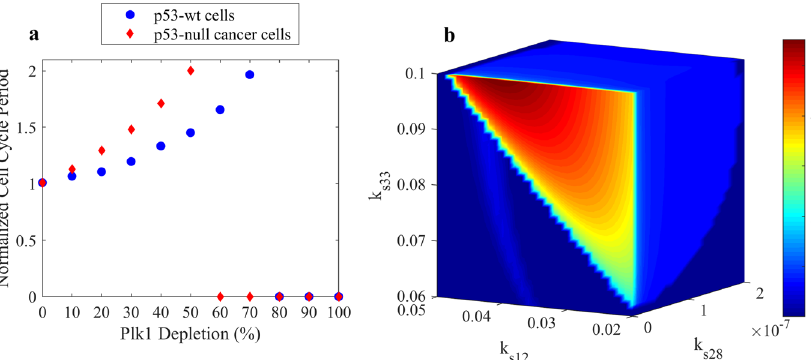
Fig. 4 The effect of Plk1 depletion on the cell cycle progression in p53-wild-type and p53-null cancer cells. a The change of the cell cycle period in Plk1-depleted p53-wt (blue circles) and p53-null cancer (red diamonds) cells. The cell cycle periods of Plk1-depleted cells were computed for 10 – 100% Plk1-depletion levels and normalized by the cell cycle periods of corresponding unperturbed cells. Plk1 depletion above 50% causes a cell cycle arrest in p53-null cancer and only a cell cycle progression delay in p53-wt cancer cells. b The dependence of Mad2:Cdc20P complex concentration (relative to CDK1 concentration) on p53 synthesis rate ( k s28 ), Plk1 synthesis rate ( k s12 ), and Mad2 synthesis rate ( k s33 ) parameters controlling levels of p53, Plk1, and Mad2 in cells. Mad2:Cdc20P complex concentration values are shown in the color bar and are highest (red) for k s28 = 0, k s12 = 0, and k s33 = 0.1 when p53 and Plk1 concentrations are low and Mad2 concentration is high. The color code bar shows the level of Mad2:Cdc20P complex